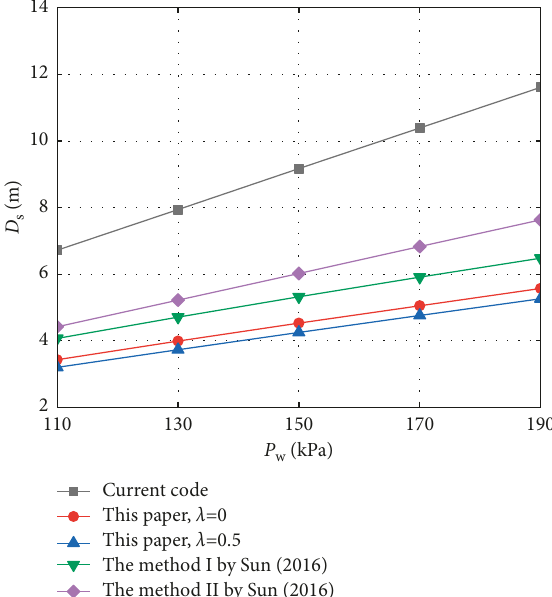
Figure 5: Critical safety thickness of the base corresponding to B × L � 8 m × 16m.